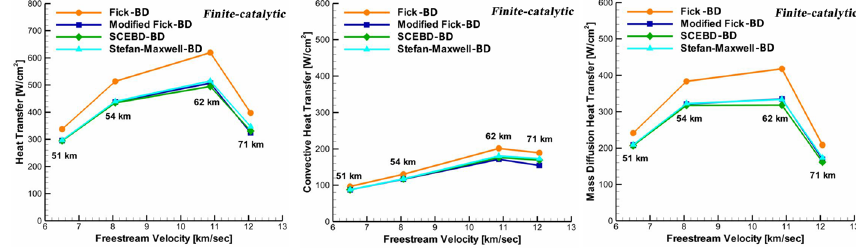
Fig. 12 Total, convective, and diffusion heat transfers at the stagnation point of the Stardust Sample Return Capsule with different diffusion models